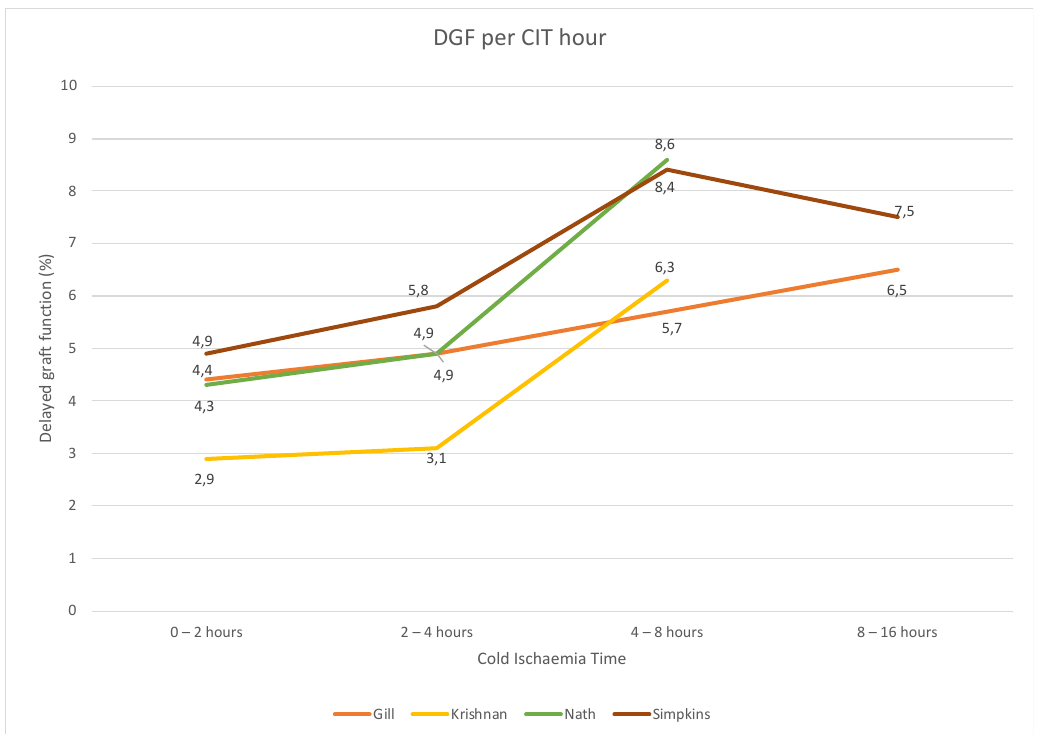
Figure 4. The incidence of DGF for 0–2, 2–4, 4–8 and 8+ hours of CIT. The studies included are Gill et al. [11], Krishnan et al. [30], Nath et al. [31] and Simpkins et al. [35]. CIT: cold ischaemia time; DGF: delayed graft function.